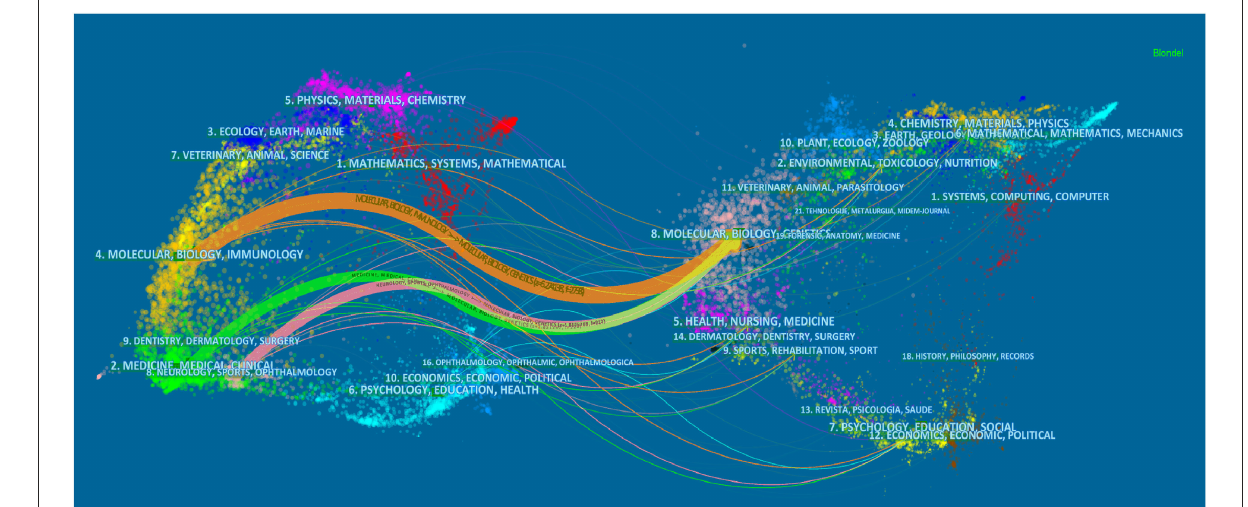
FIGURE4 The dual-map overlay of journals. The left side correspond to the citation map and the right side represent the cited journal map. Molecular/biology/immunology journals represented by the yellow path, medicine/ medical/ clinical journals represented by the green path, and neurology/sports/ophthalmology journals represented by the pink path are cited in molecular/biology/genetics